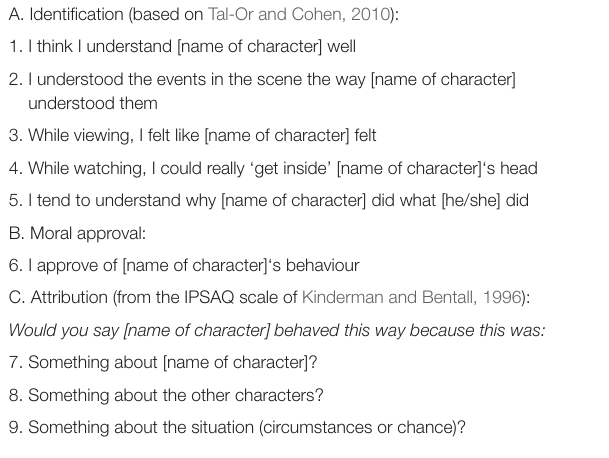
TABLE 1 | Questions completed by participants after watching each play